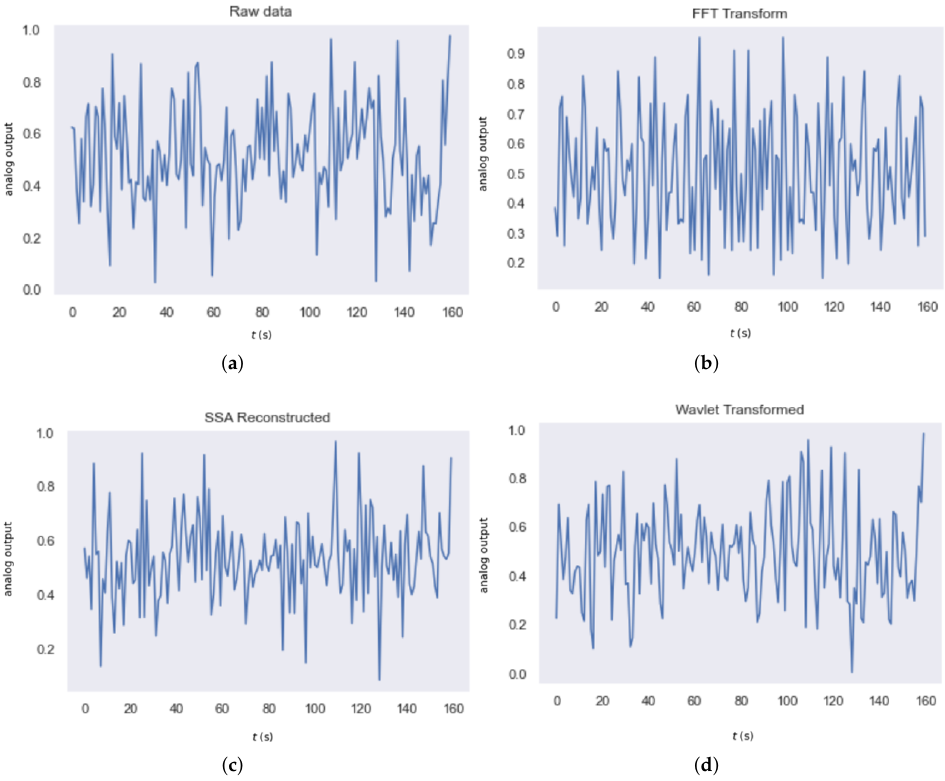
Figure 8. Results of the data conversion ( a ) gathered original data, ( b ) data extracted through Fourier transform, ( c ) data re-generated using the SSA technique, and ( d ) data extracted through wavelet transformed data.